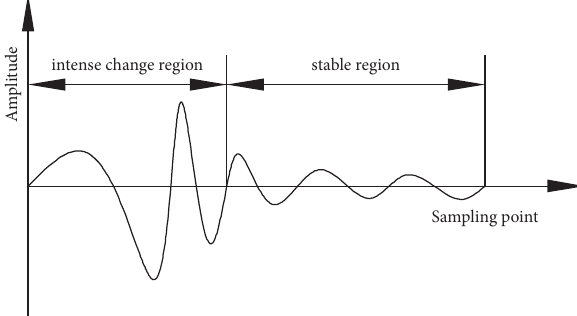
Figure 3: The “intense change region” and the “stable region” of impact fault